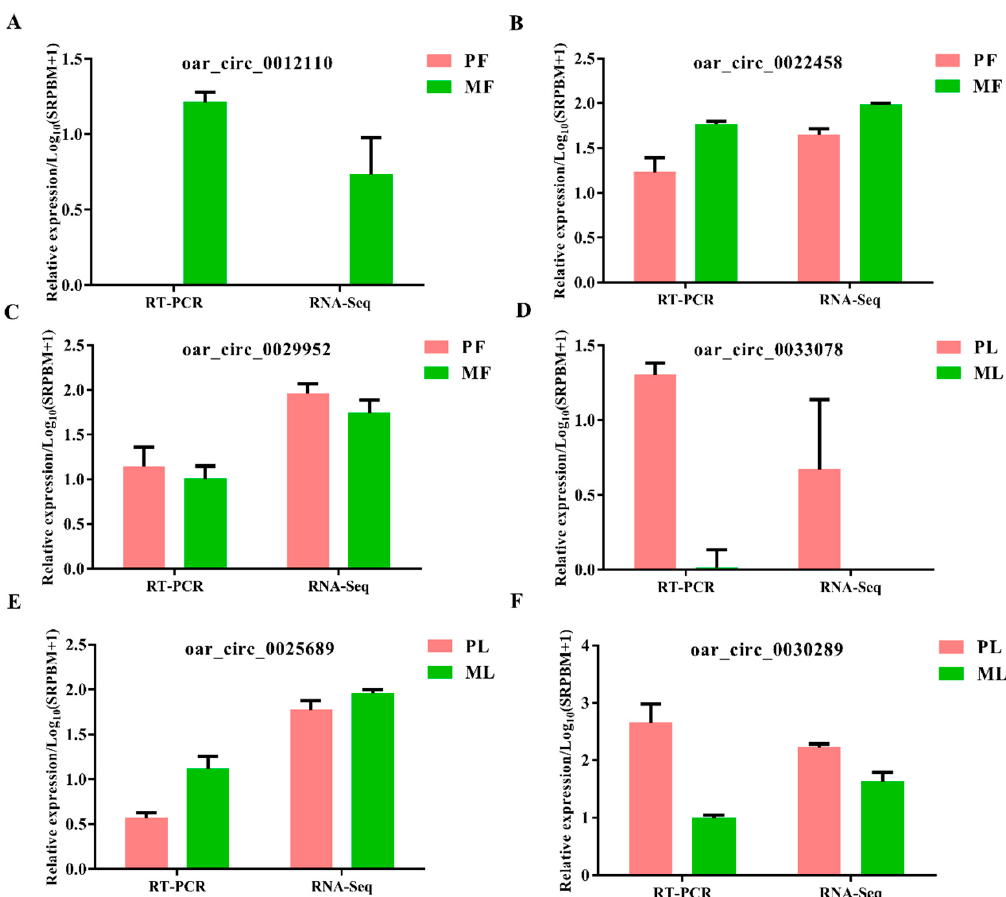
Figure 5. Validation results of three selected circular RNAs in polytocous sheep in the follicular phase (PF) and polytocous sheep in the luteal phase (PL) ( A – C ); Validation results of three circular RNAs in monotocous sheep in the follicular phase (MF) and monotocous sheep in the luteal phase (ML) ( D – F ) by real-time quantitative polymerase chain reaction (RT-qPCR).